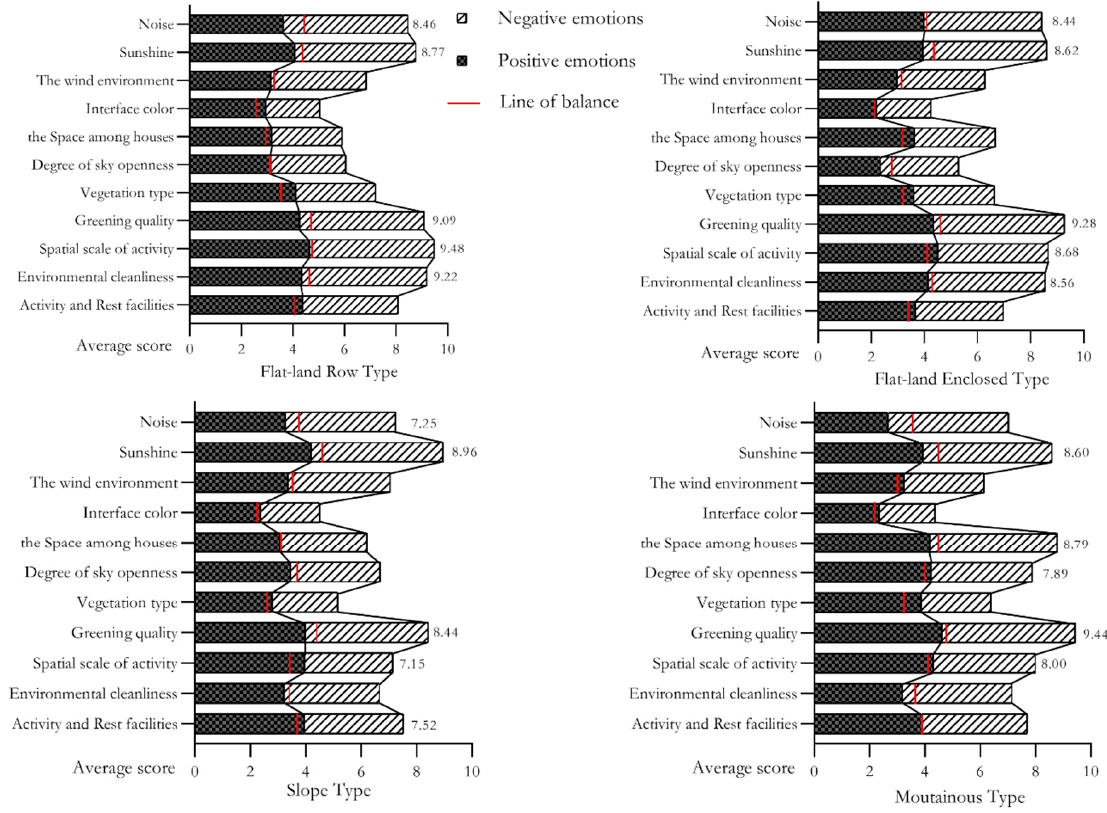
Figure 3. The elderly's choice of environmental quality by two emotional types in different residential environments.